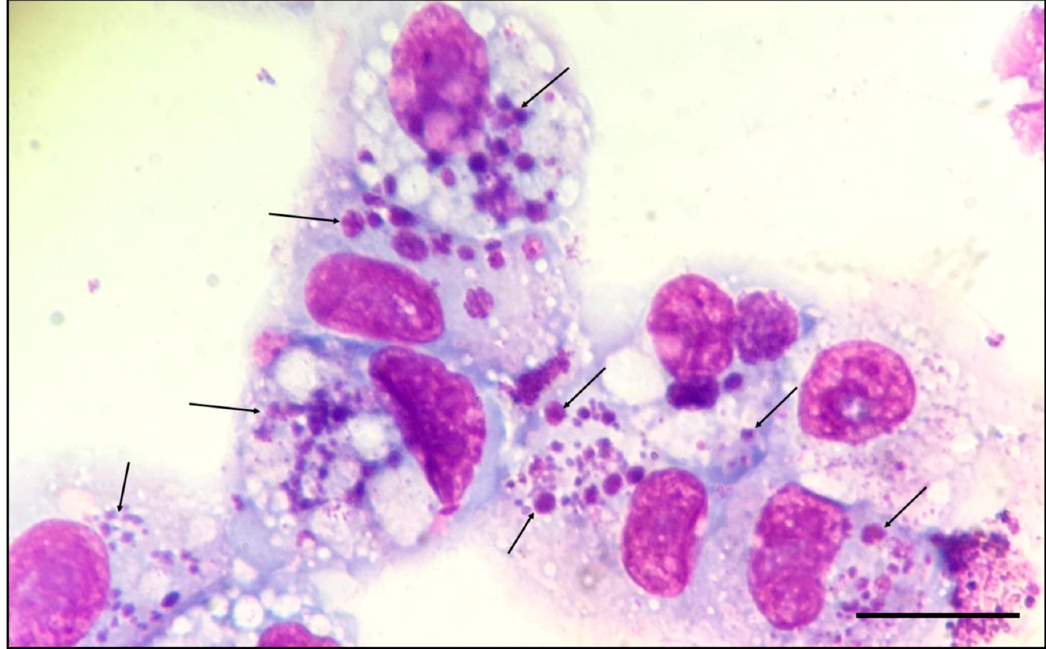
Figure 2. Romanowsky-stained stained smear showing morulae of E. minasensis (arrows) in the cytoplasm of DH82 cells. Magnification, 1000×. Bar = 10 µm.